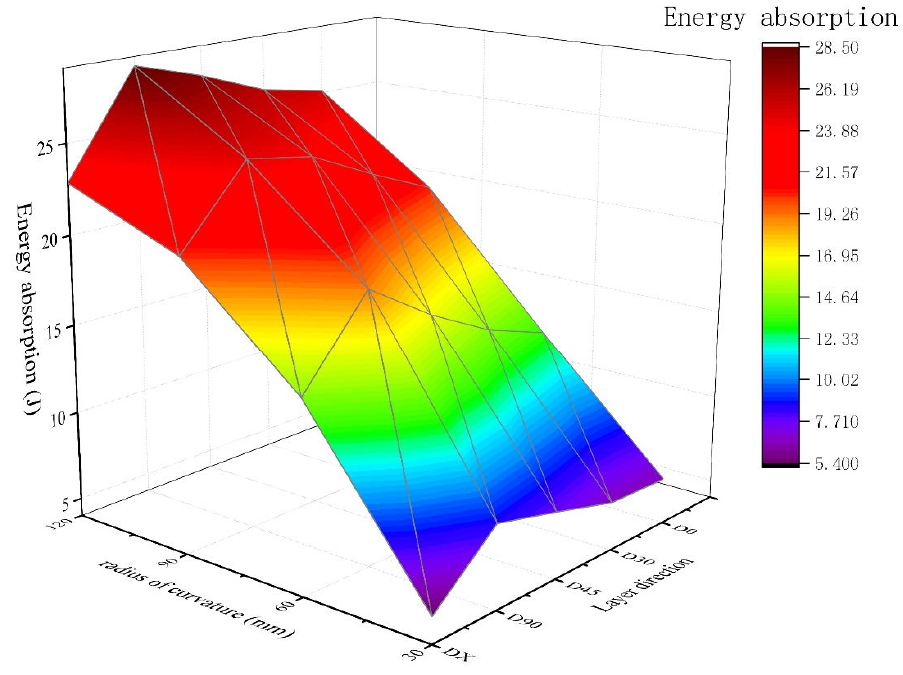
Figure 22. Maximum deformation vs. fiber layering direction and radius of curvature.